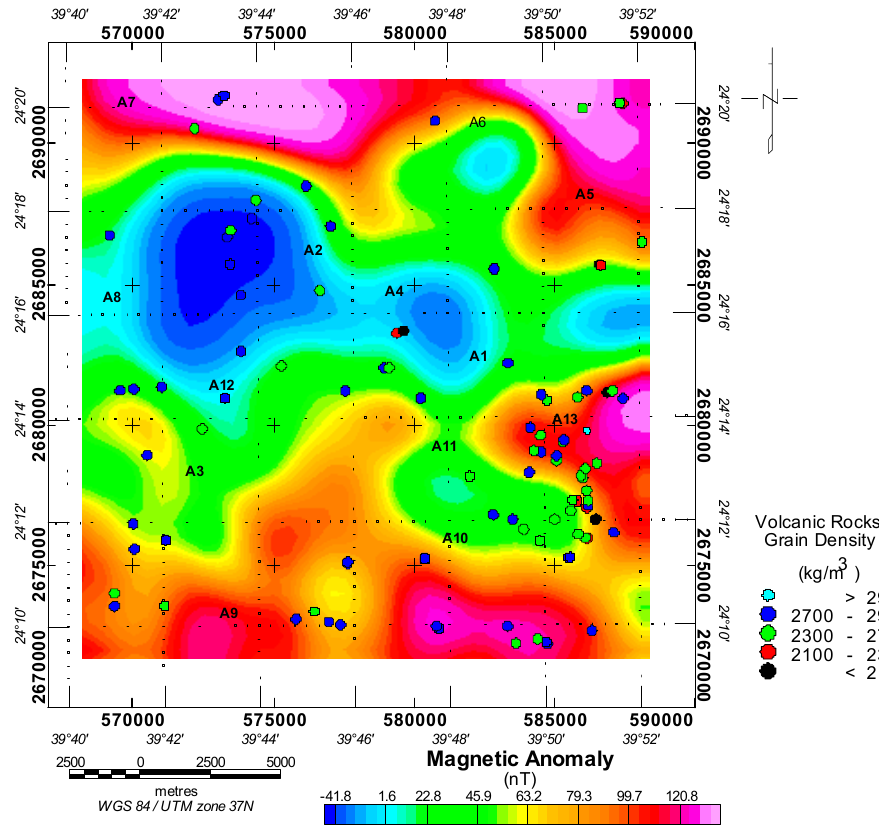
Figure 7. The magnetic anomaly map of the study region. A low magnetic susceptibility feature can be noticed within the central region of the study area. The location of the rock samples obtained for the density analysis [27] is plotted on the map.